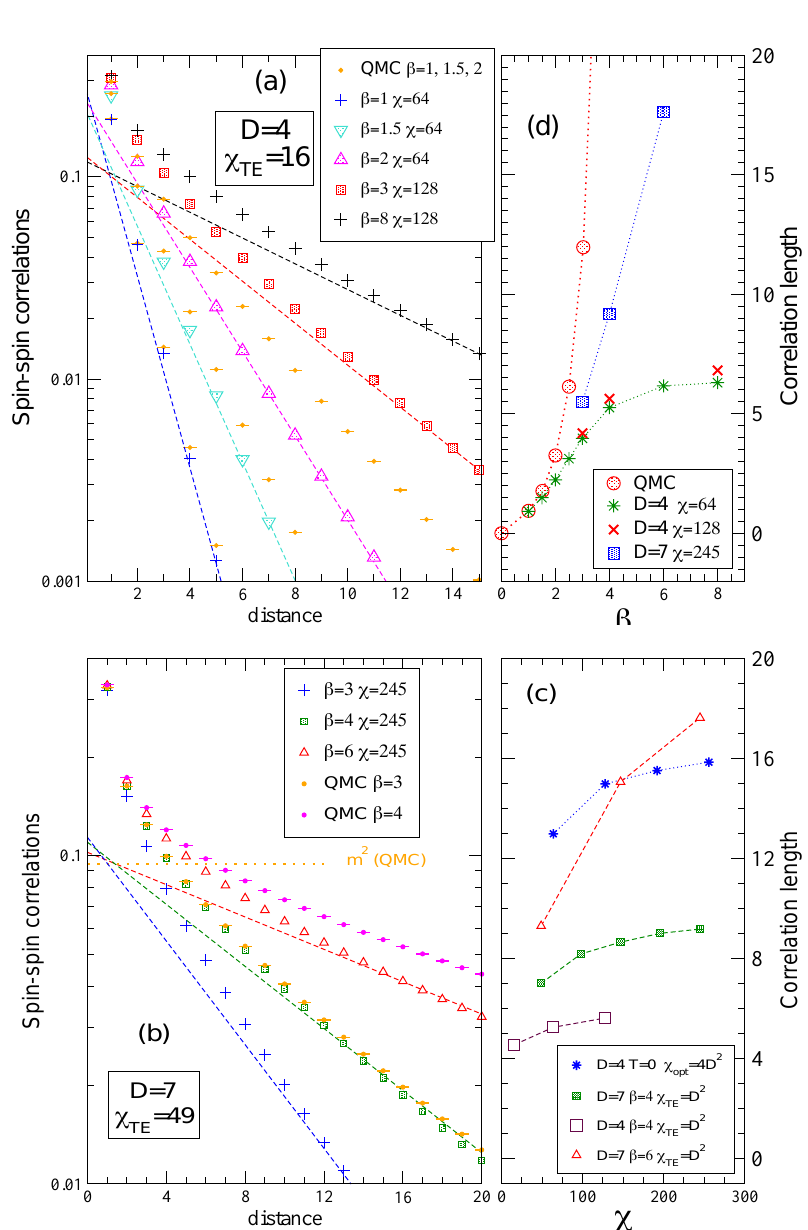
Figure 6: (a) Spin correlation function versus distance in semi-log scales, for D = 4 = D 2 . Exponential fits of the long (a) and D = 7 (b) tensors optimized with χ TE distance behavior (not shown) are indicated as dashed lines. Converged QMC results are also shown, obtained on 64 × 64 ( β = 1,1.5 and 2 data displayed from bottom to top) (a) and 256 × 256 systems (b). m 2 corresponds to the T = 0 long-distance correlation. (c) Scaling of the spin correlation length w.r.t. χ , for a few values of the temperature and D = 4,7. The largest available values of χ are used in (a) and (b). Extracted spin correlation lengths are plotted vs β in (d), and compared to QMC. Note that in (b) and (d), the data for D = 7 and β = 6 are not fully converged in χ